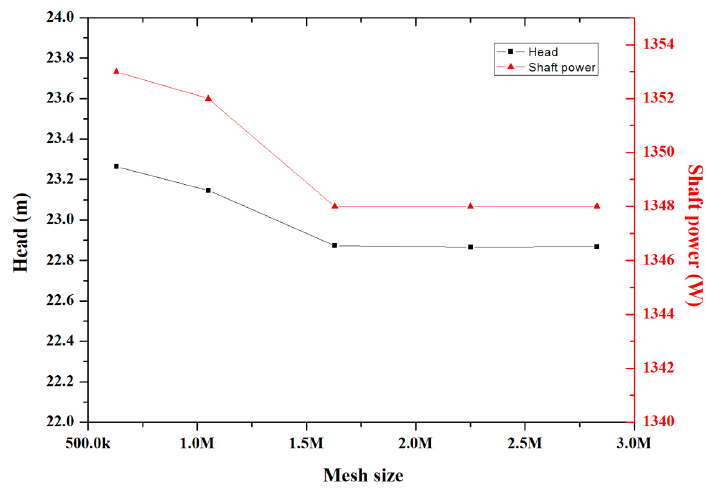
Figure 3. Results of mesh sensitivity test at the designed flow rate.